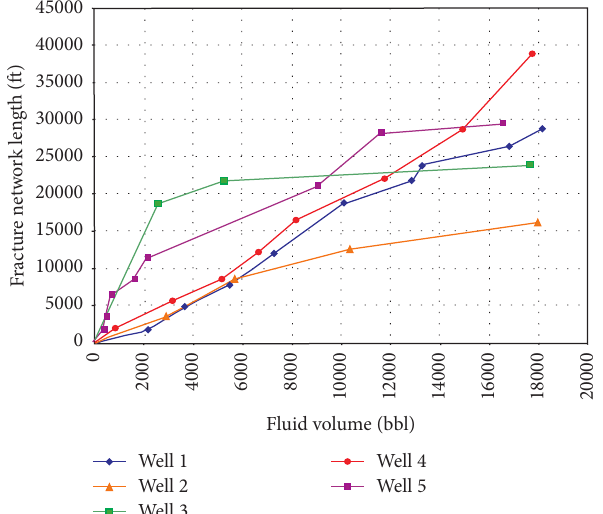
Figure 14: Relationship between total fracture network length and total pumped fluid volume [20].